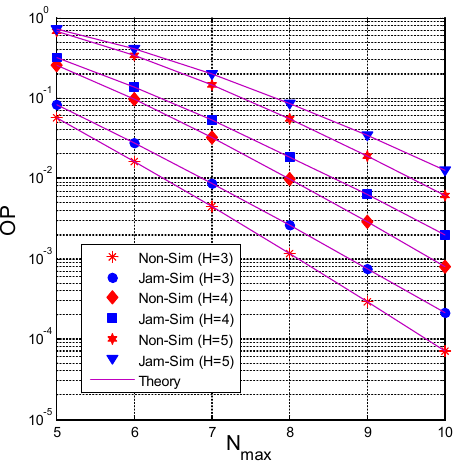
N when 7.5dB, D= max 5. M =